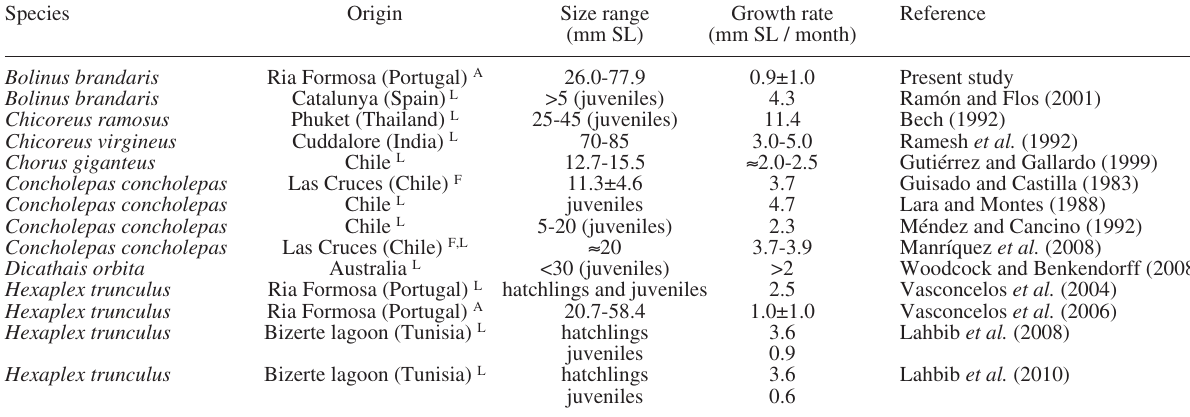
fisheries and/or aquaculture.